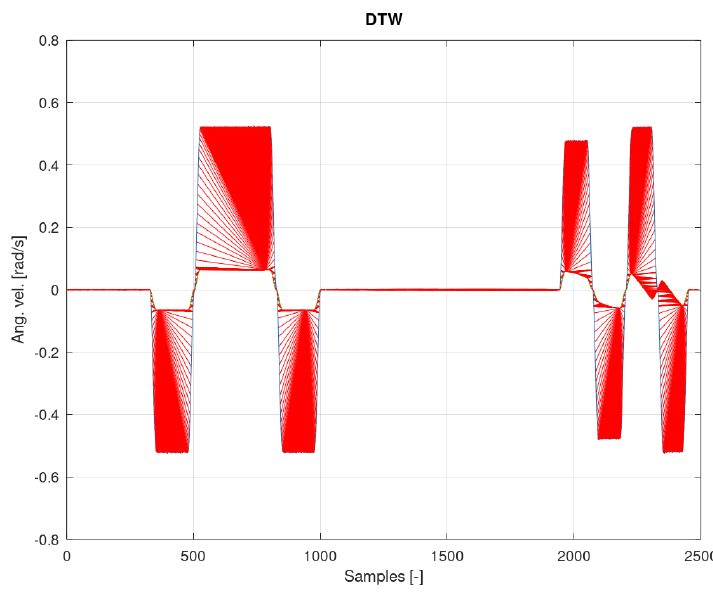
Figure 13. Analysis of the error from Figure 12 with the DTW algorithm.